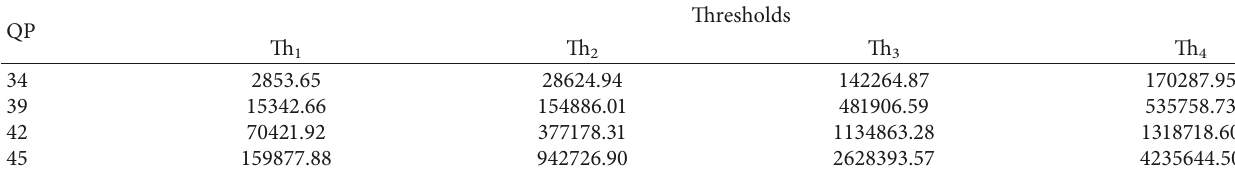
Table 5: The size decision model thresholds for each depth map quantization